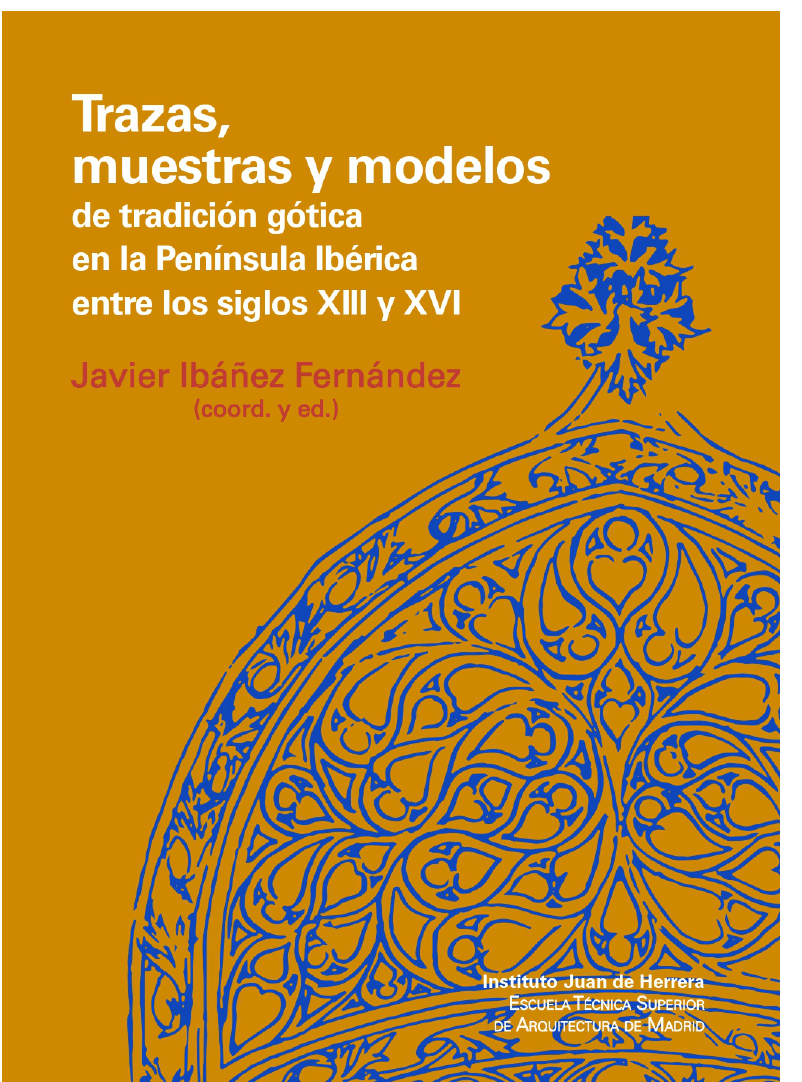
Figure 1. Book cover of Ibáñez Fernández